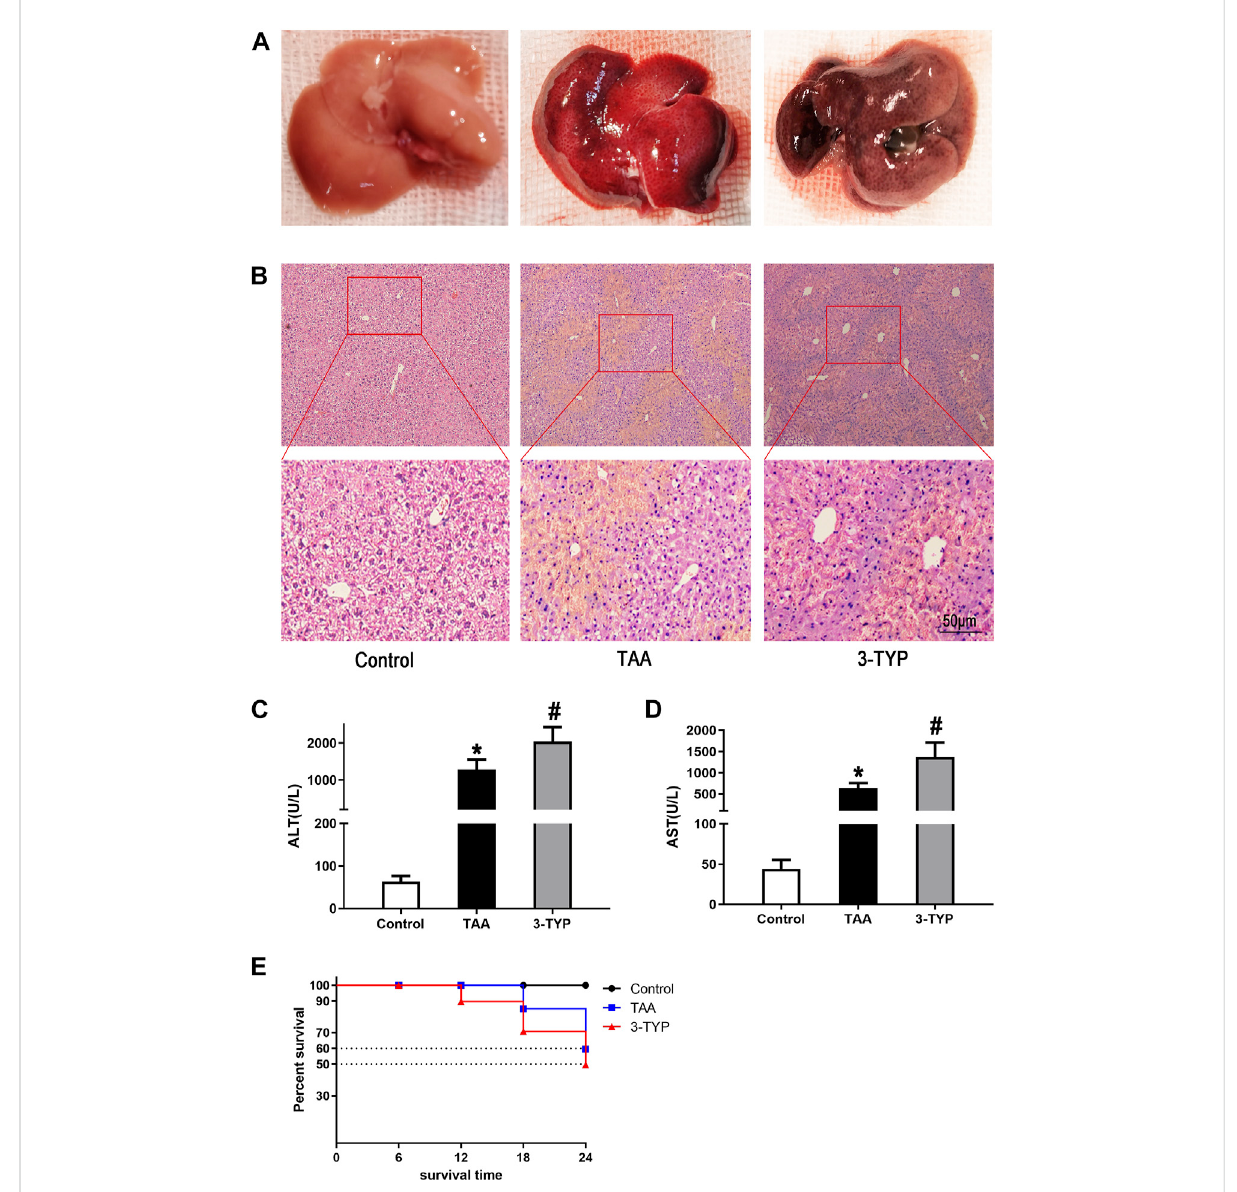
Effect of 3-TYP on liver damage and survival rate in each group, n = 10 per group. (A) The gross morphology of liver tissues. (B) HE staining of liver tissues. (C) serum ALT levels. (D) serum AST levels. (E) The 24 h survival rates of mice. * p < 0.05, vs . the control group. # p < 0.05, vs . the TAA